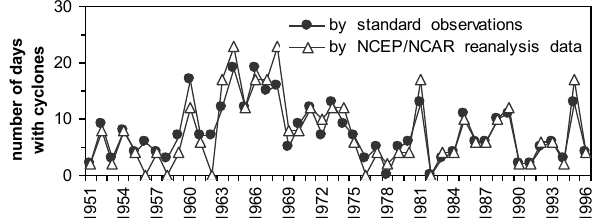
Figure 3. Number of days with cyclonic conditions in the Black Sea region in November obtained using NCEP/NCAR reanalysis data sets and composite-kinematic maps of the Ukrainian Hydrometeorological Service.